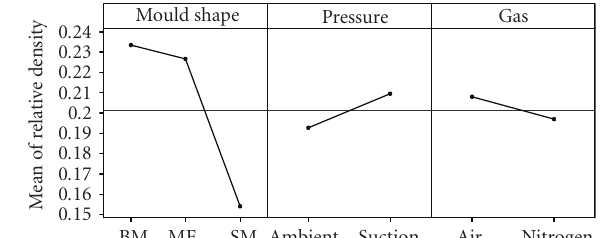
Table 2: Mould filling ability.